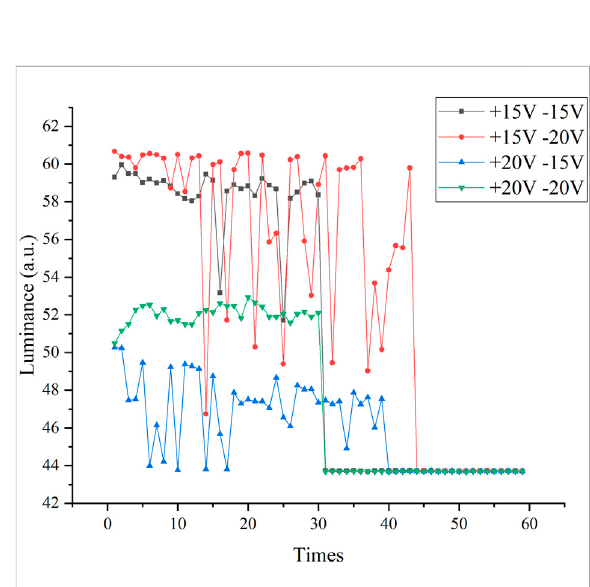
FIGURE 10 Re fl ected luminance of different driving voltage